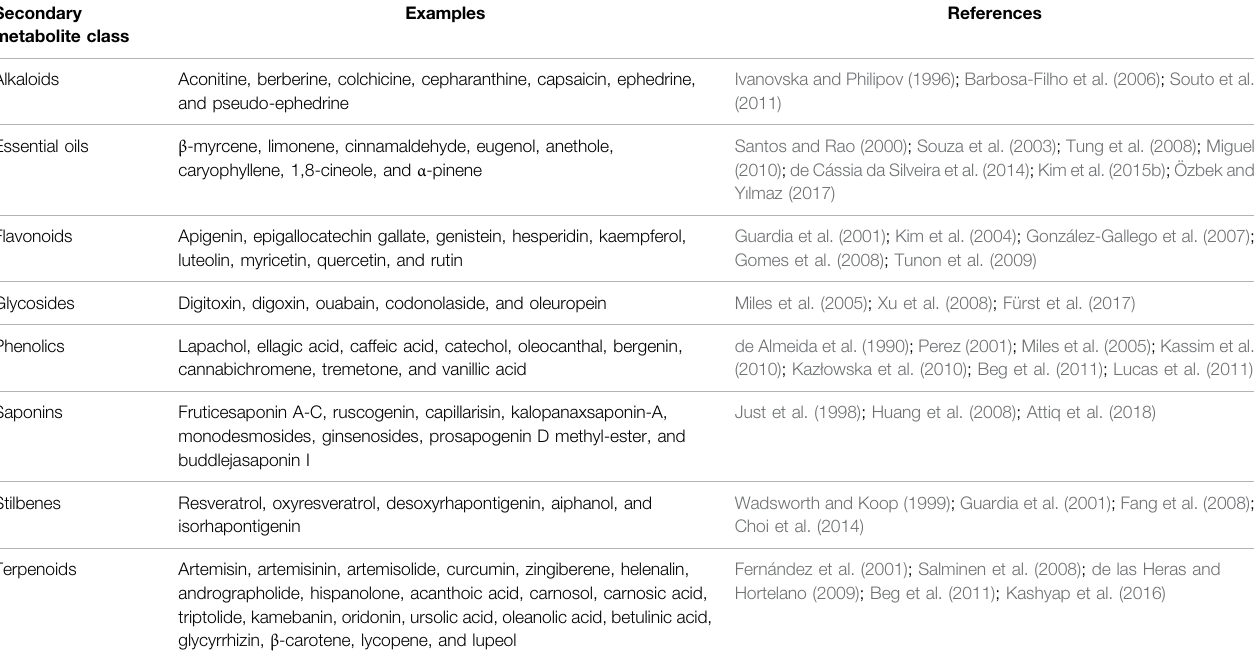
TABLE 2 | Major chemical classes of plant-derived anti-in fl ammatory